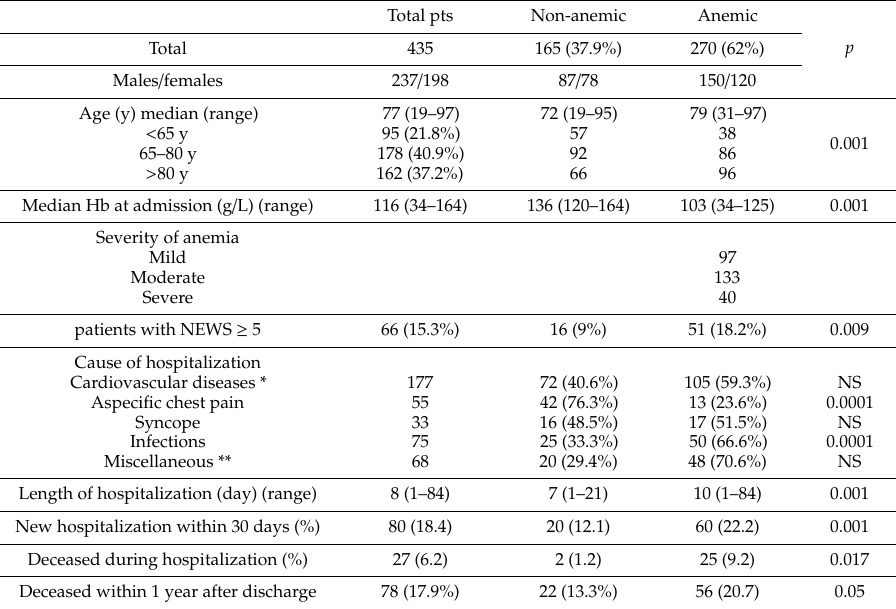
Table 1. Baselines characteristics and outcomes of all patients admitted in our Internal Medicine Department over 5 months accordingly with their anemic